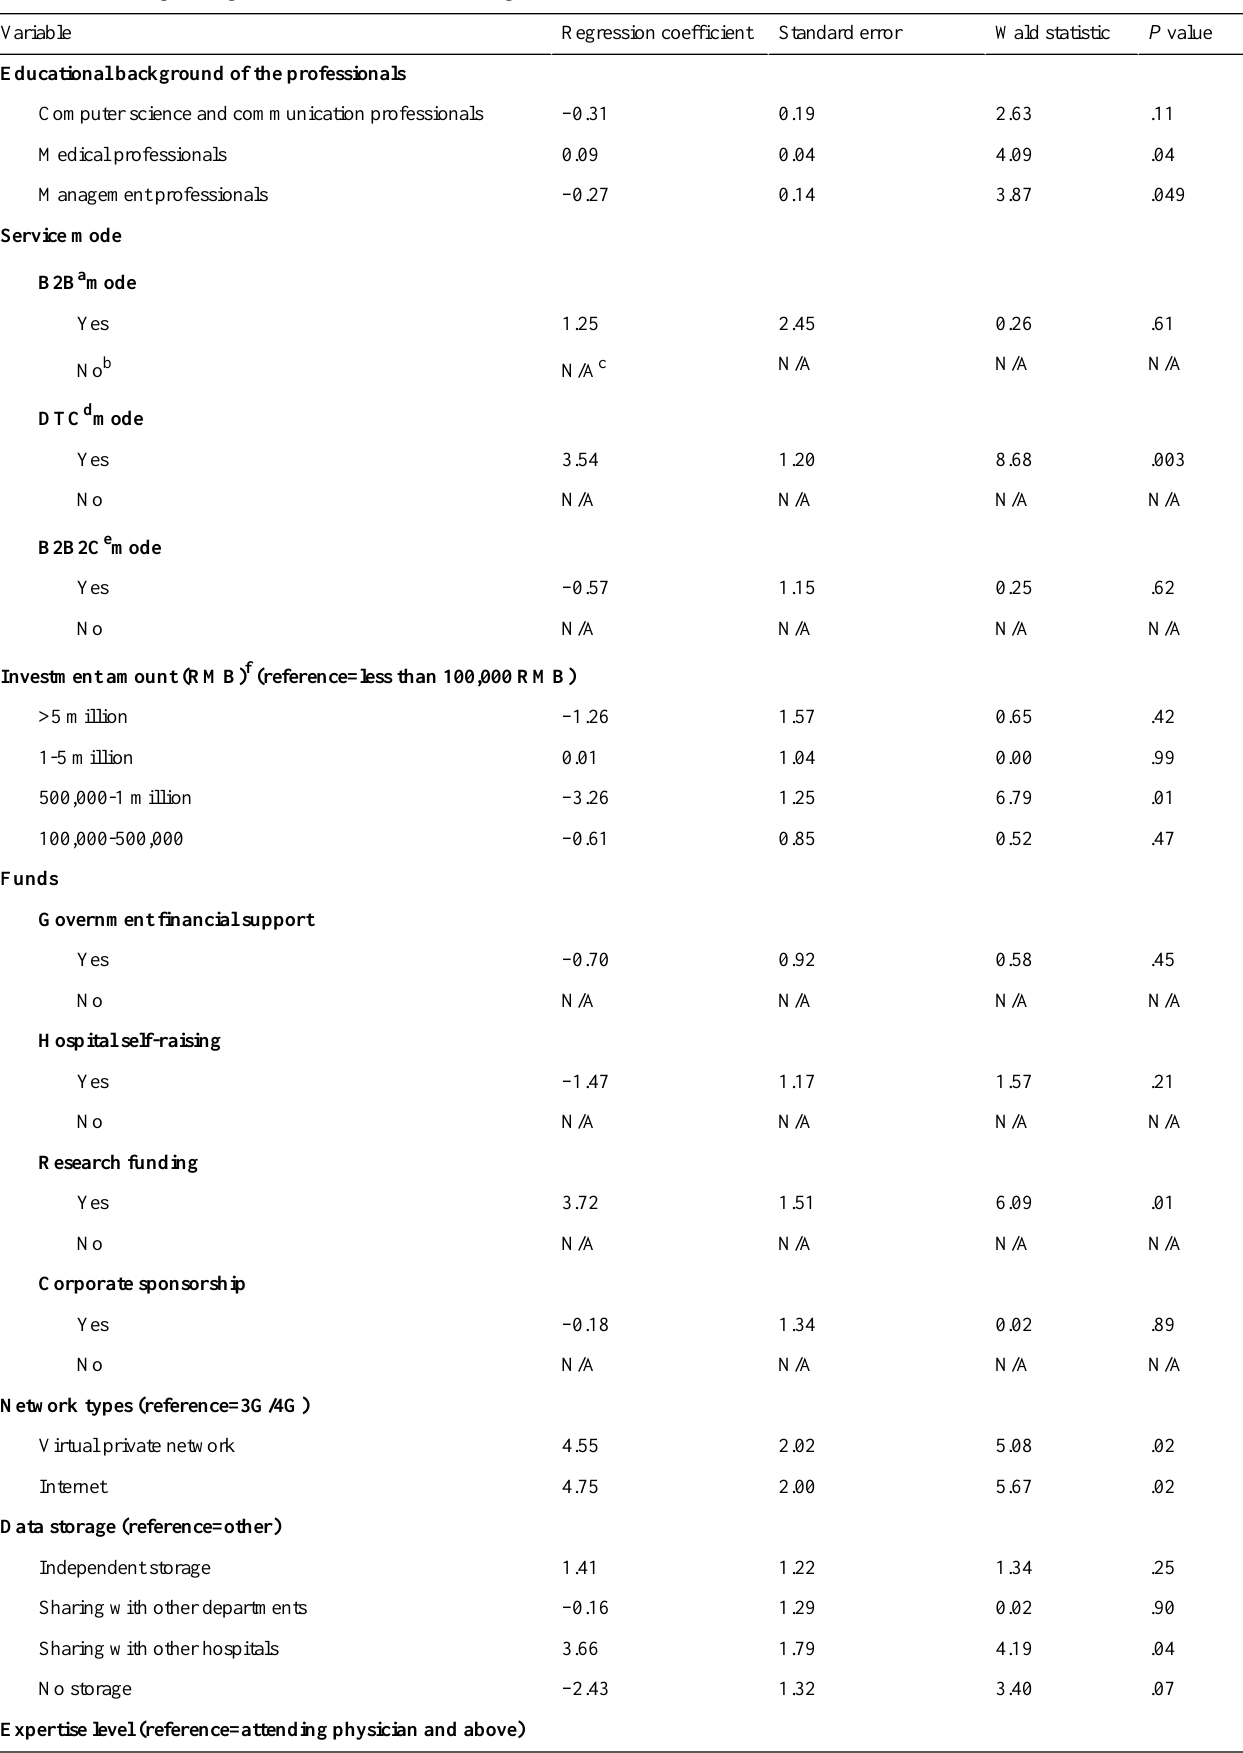
Table 6. Ordinal logistic regression results of the influencing factors of the consultation effect.